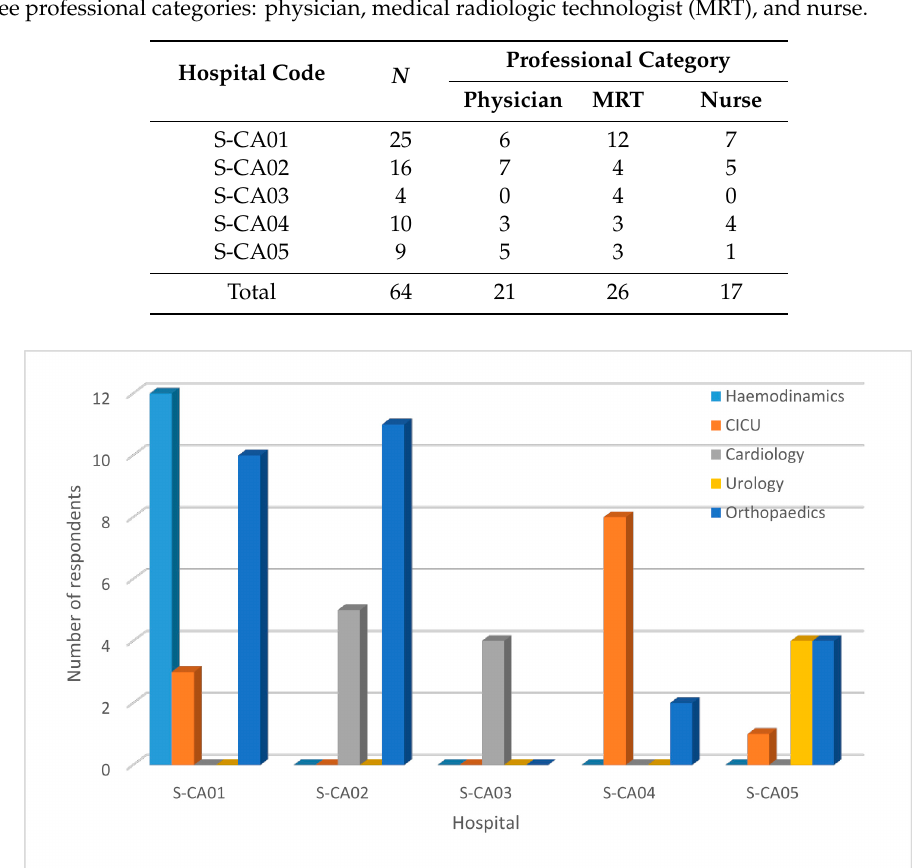
Figure 1. Distribution of respondents across hospitals and departments.